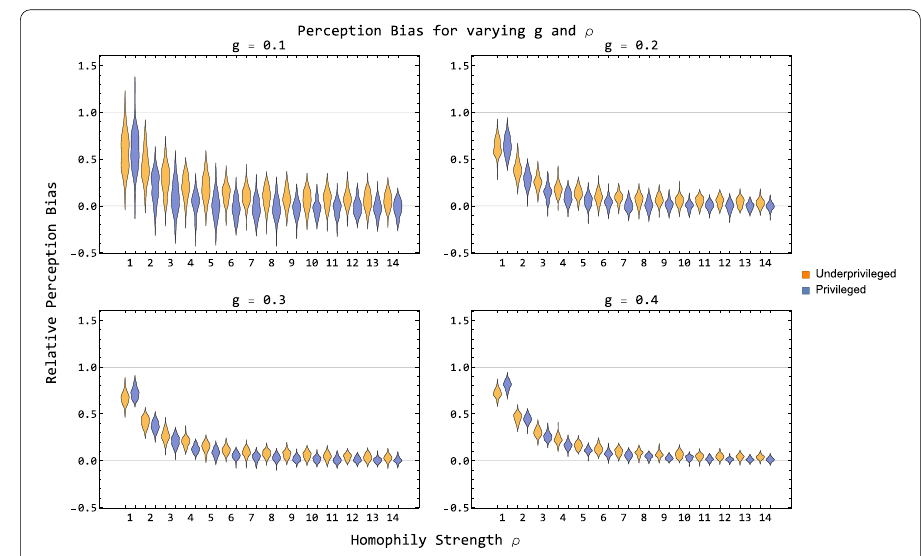
Fig. 3 Violin plots of perceived wage gap p i relative to the true wage gap g for various g and